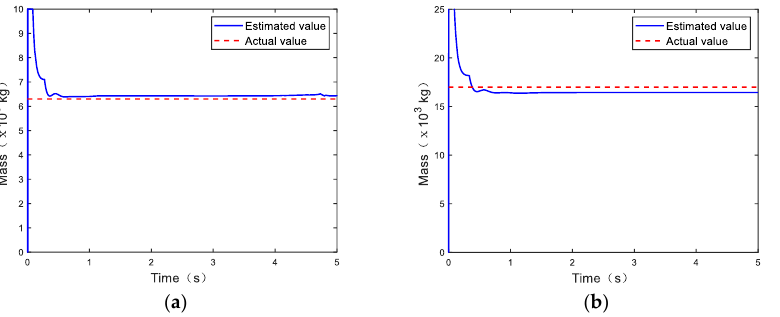
Figure 5. Mass estimation based on the starting state of the vehicle. ( a ) Unladen mass estimation results; ( b ) full load mass estimation results. results; ( b ) full load mass estimation results. Table 2. Summary of vehicle mass estimation results. Table 2. Summary of vehicle mass estimation results.